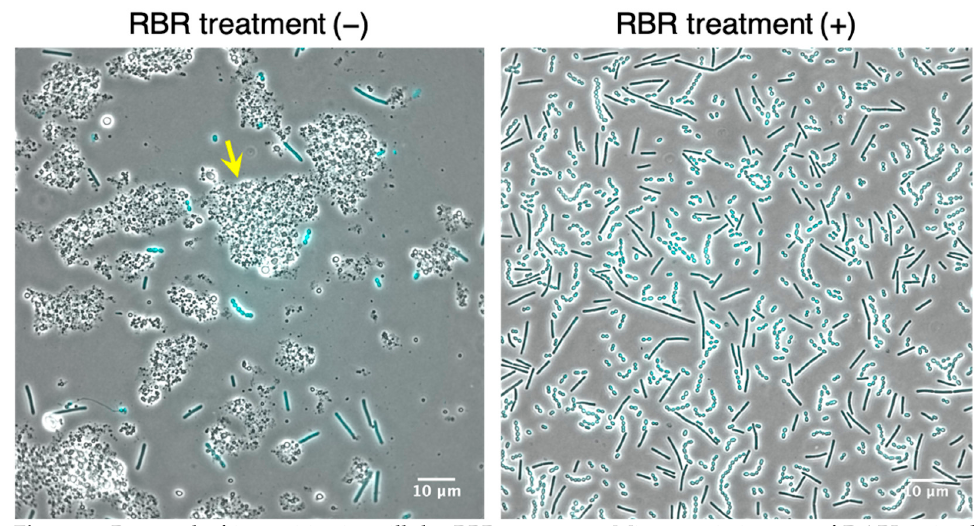
Figure 1. Removal of impurities in milk by RBR treatment. Microscopic images of DAPI-stained LAB cells collected from 8.0 h-fermented yogurt with and without the RBR treatment. Arrow indicates aggregated impurities.